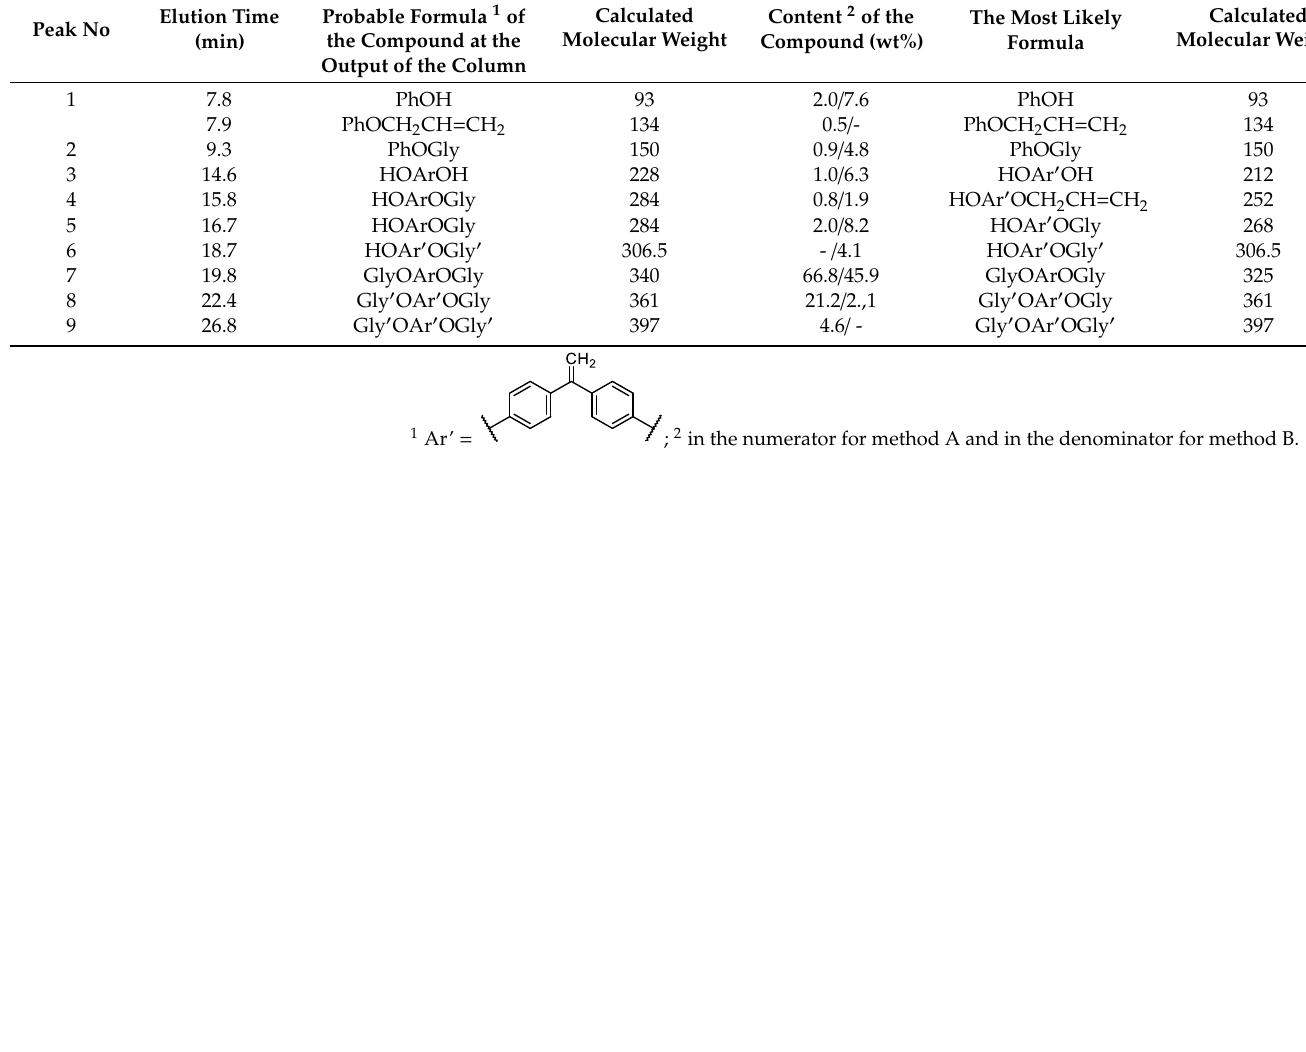
Table 2. Results of chromatography-mass spectrometric analysis of organic fractions of